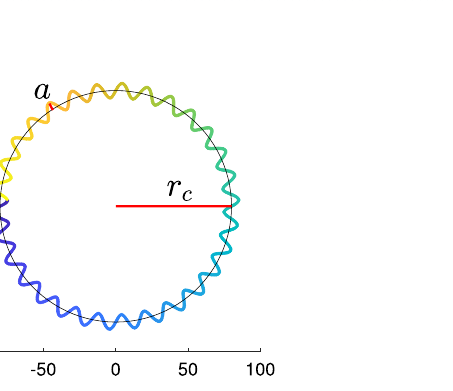
Figure 12. Trajectory of simulated circular swimming cell.